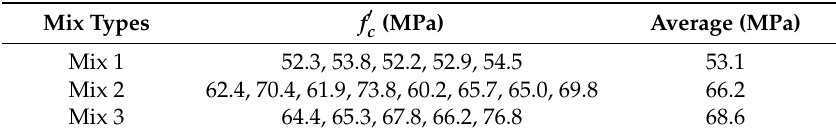
Table 2. Measured compressive strength of concrete cylinder according to the case of mix proportion.